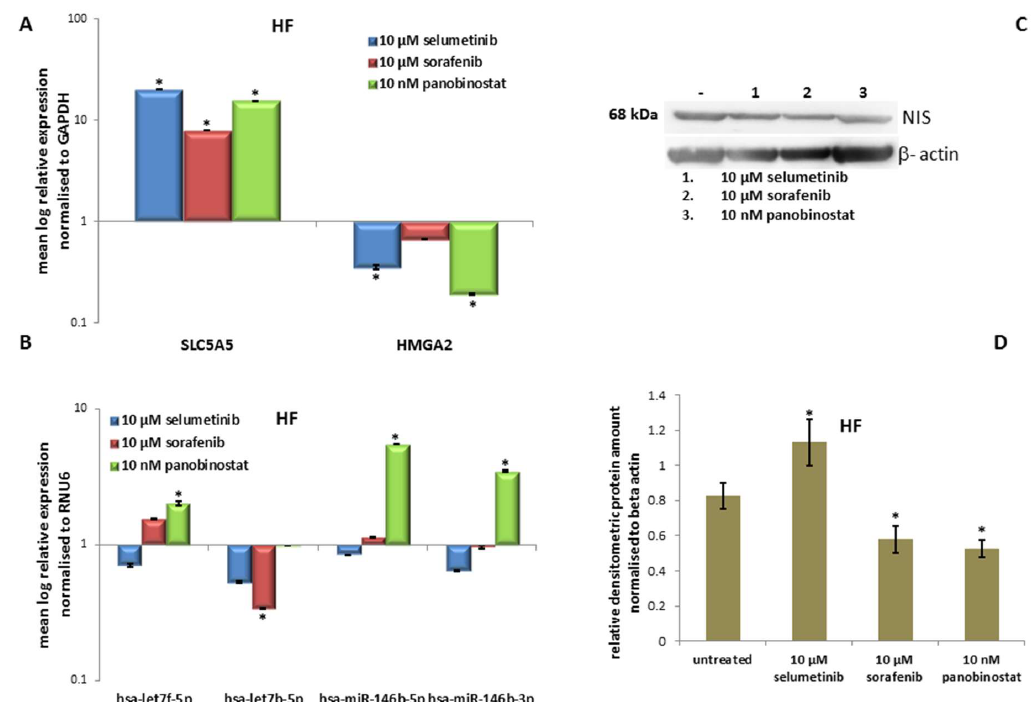
Figure 12. Effects of selumetinib, sorafenib and panobinostat on mRNAs, miRNAs and NIS protein expression in HF. RT-qPCR of NIS , HMGA2 ( A ), hsa-let7f-5p, hsa-let7b-5p, hsa-miR-146b-5p and hsa-miR-146b-3p ( B ). The expression was normalised to GAPDH ( A ) and RNU6 ( B ) set at 1.0. Shown are means of experiments performed in triplicates ± SEM. * p < 0.05 regarded as significant. Western blot detection of NIS protein in HF cells treated with 10 µM selumetinib, 10 µM sorafenib and 10 nM panobinostat ( C ). Beta-actin was detected as quality loading control. ( D ) Densitometry of NIS protein level normalised to beta-actin. Shown are means of experiments performed in triplicates ± SEM. * p < 0.05 regarded as